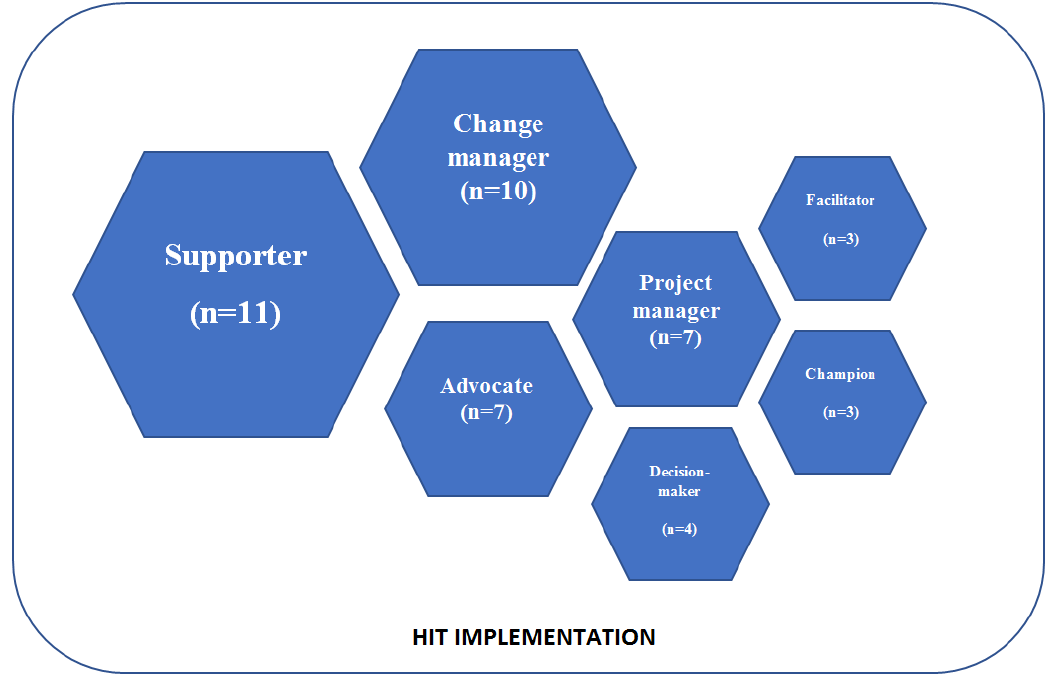
Figure 2. Healthcare leaders’ roles in HIT implementation (n = number of appearances in the included